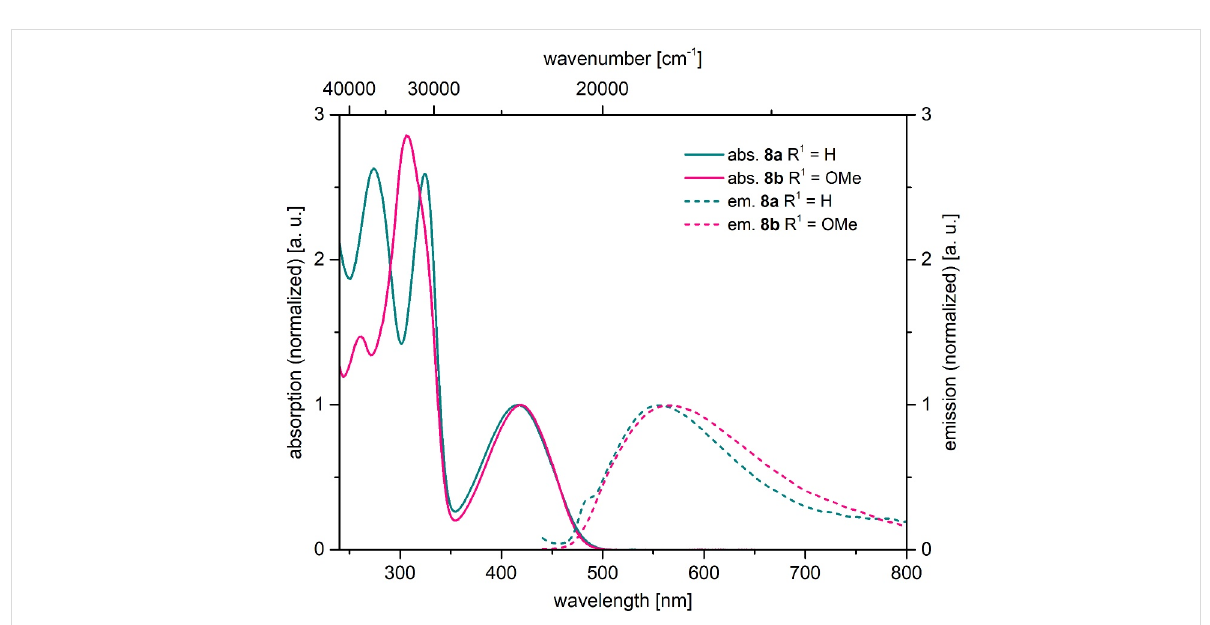
Figure 6: Selected normalized absorption (solid lines) and emission (dashed lines) spectra of 1 H -pyridines 8a and 8b (recorded in dichloromethane at T = 298 K).